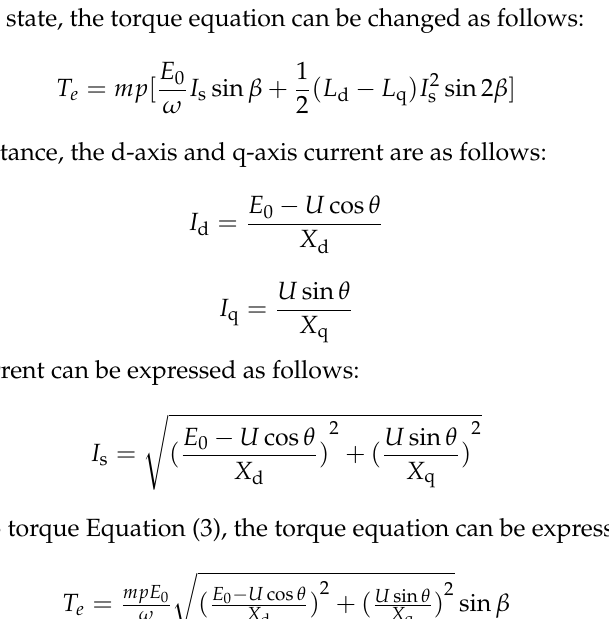
Figure 1. The vector diagram.